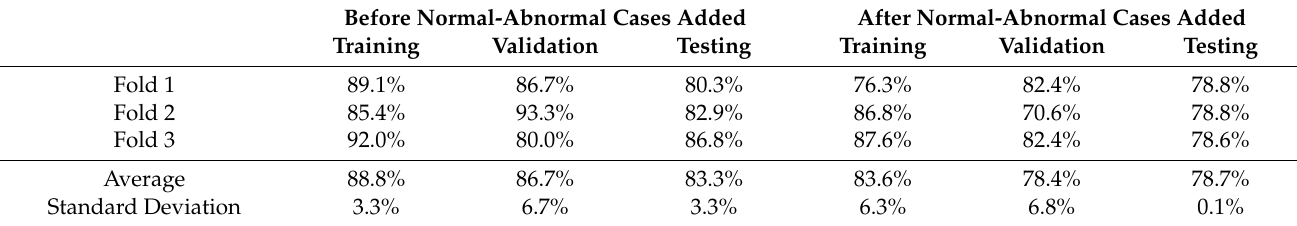
Table 2. Transfer learning classification accuracies for single images as normal or